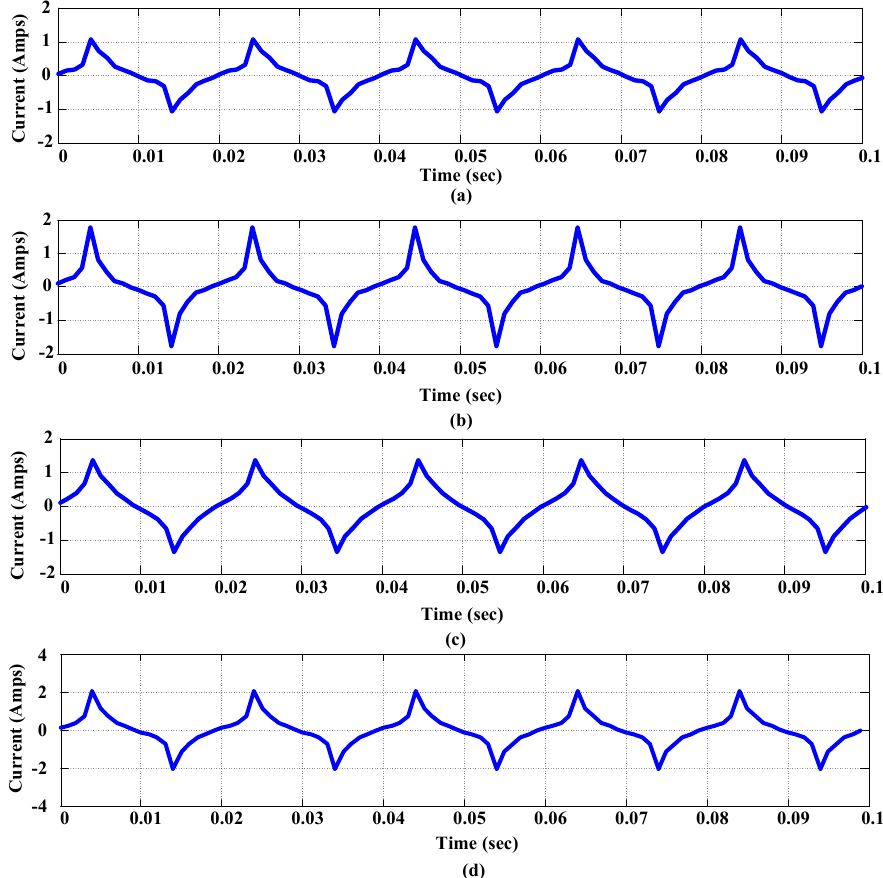
Figure 7. Any three loads. ( a ) CFL + LED + exhaust fan load waveform; ( b ) CFL + LED + SMPS of the PC load waveform; ( c ) LED + exhaust fan + SMPS of the PC load waveform; ( d ) CFL + exhaust fan + SMPS of the PC load waveform.